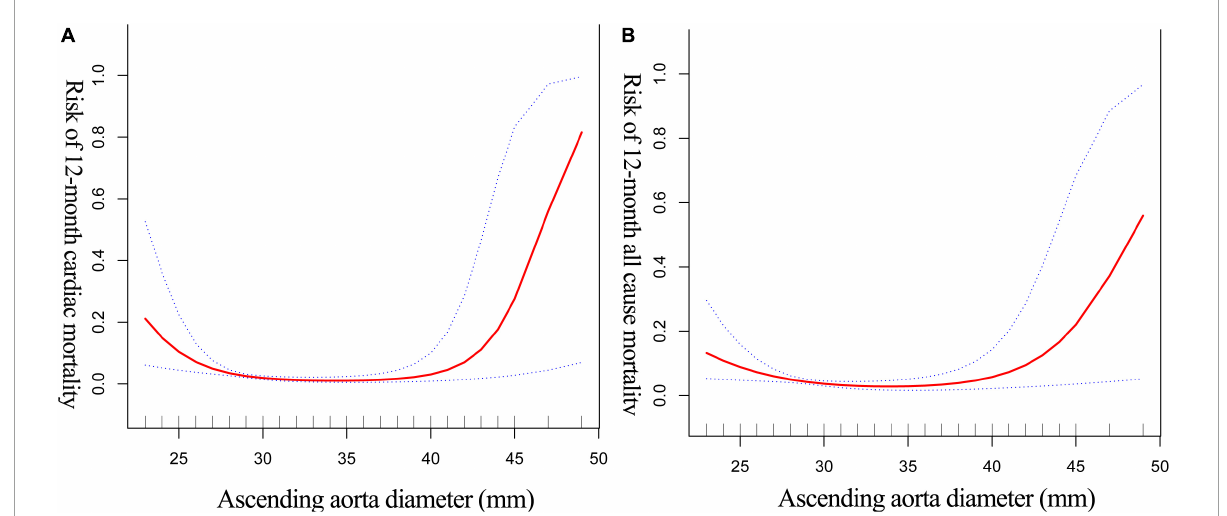
FIGURE2 The non-linear relationship between AoD and 12-month cardiac-mortality (A) all-cause mortality (B) of HF. The abscissa represents the AoD. The ordinate represents the risk of 12-month mortality in patients with HF. The middle line represents the trend of 12-month mortality with AoD. The upper and lower lines represent the 95% confidence interval.